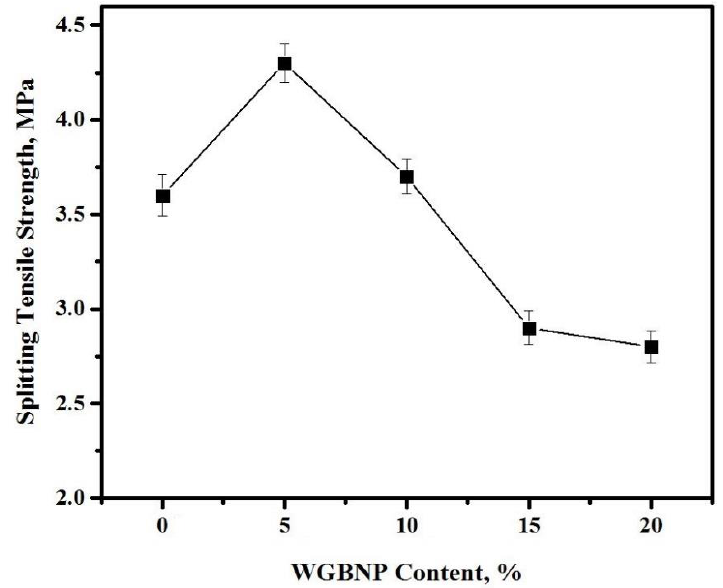
Figure 8. Influence of AAMs splitting tensile strength by BGWNP content .